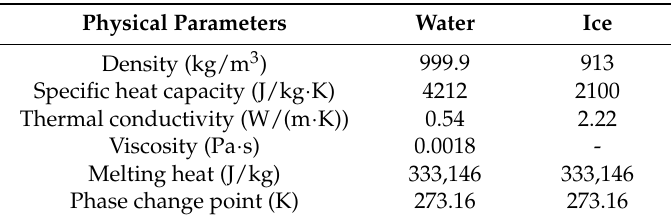
Table 1. Physical parameters of water and ice.